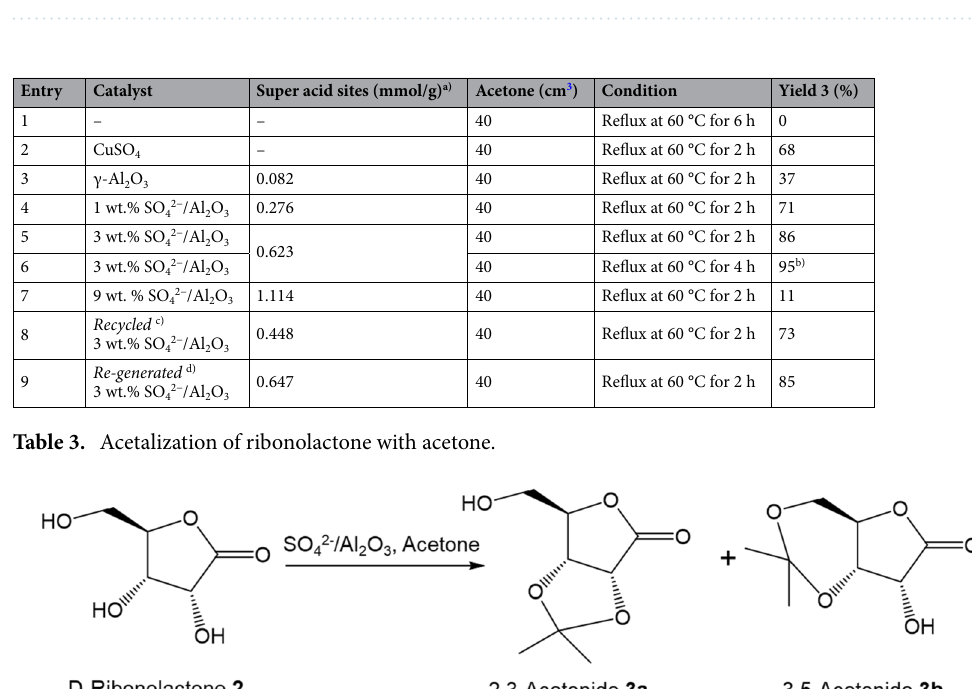
Figure 6. Conversion and selectivity of d-ribose oxidation with recycled Au/Al 2 O 3 catalyst.